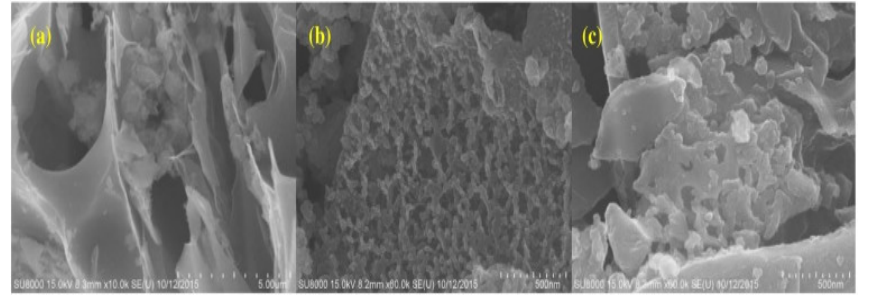
Figure 2. SEM images of: ( a ) straw AC, ( b ) Fe-SAC and ( c ) Fe-Mn-SAC. Reprinted from Xiong et al. [23] Copyright 2021 Elsevier.